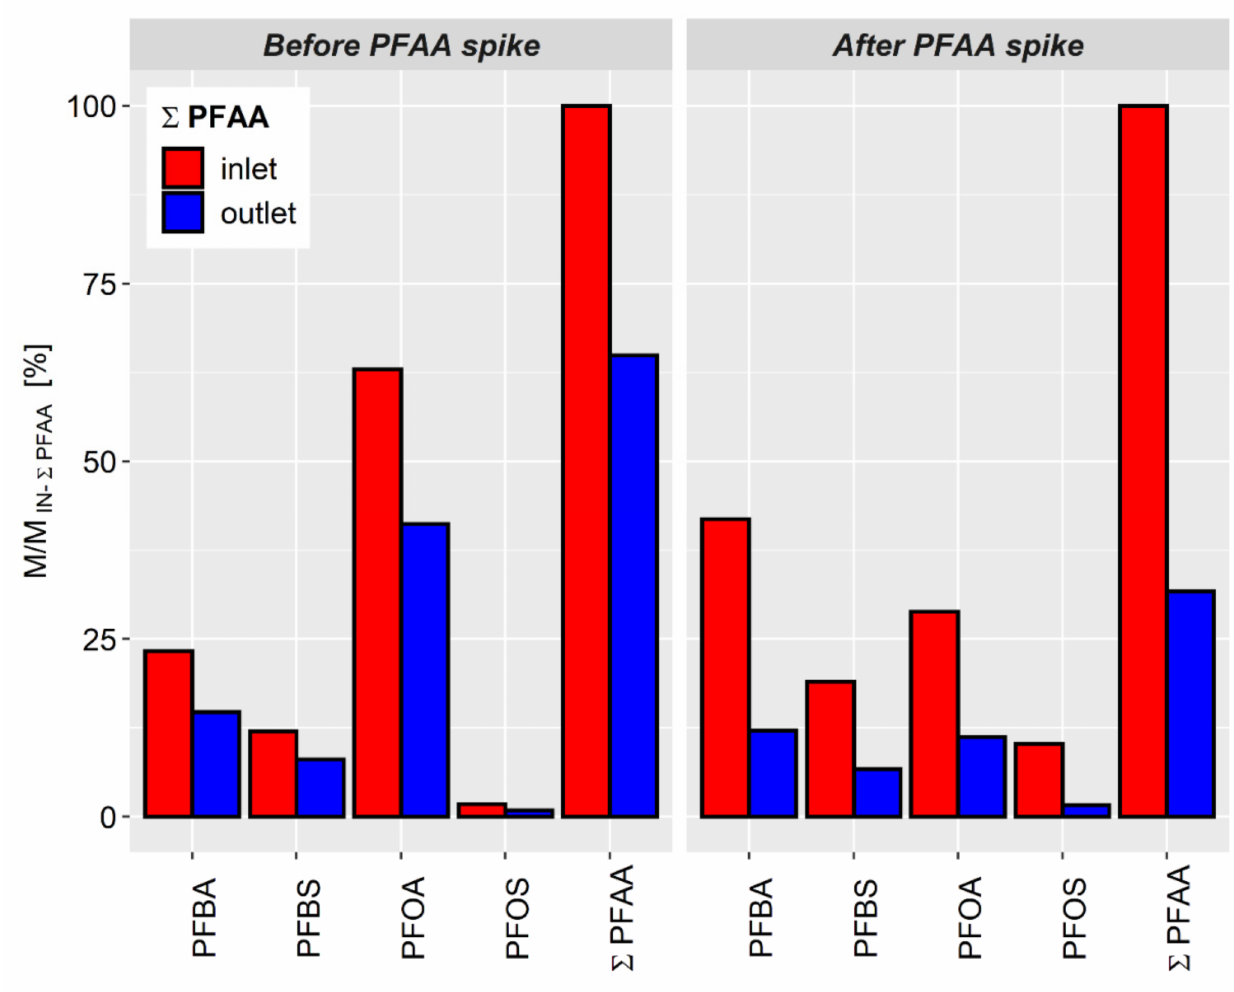
Figure 4. Normalised inlet and outlet mass flow before the PFAA spike ( left panel ) and after the PFAA spike ( right panel ). The comparison was performed between the first-day inlet data and the fifth-day outlet data since the HRT is roughly equal to 5